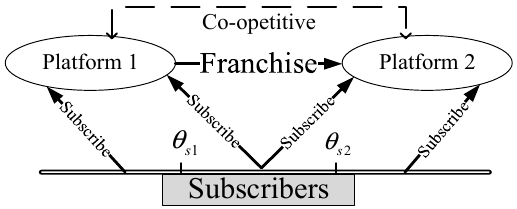
Figure 3. The case of partially multi-homing subscriber and single-homing advertiser.